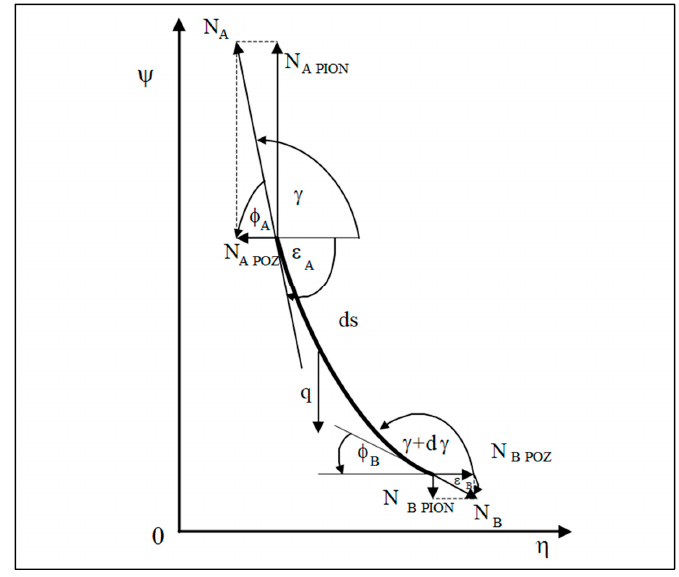
Figure 6. Geometric dependencies for the section of 9a free hanging casing [20].